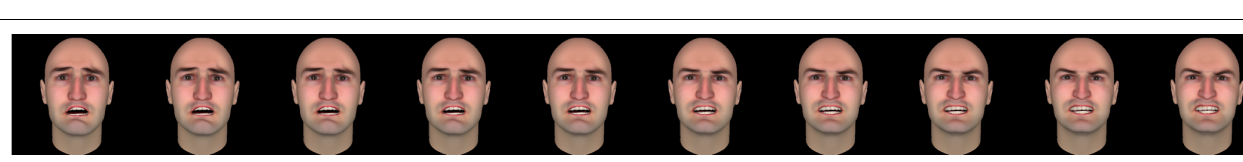
FIGURE 1 | Idealized illustrations of two possible ways a brain area could represent stimuli, when categories α and β have been learned. (A) Categorical representations. (B) Graded, noncategorical representations. The y-axis could be measured in several ways. Low values indicate the brain is in the “ α ” state. High values indicate the brain is in the “ β ”